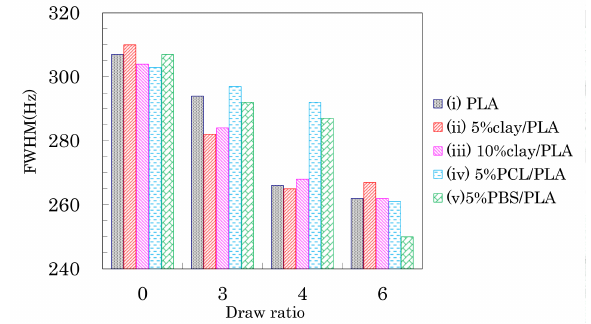
Figure 5. Full width at half maximum (FWHM) values of CH signal peaks of PLA fibers over a range